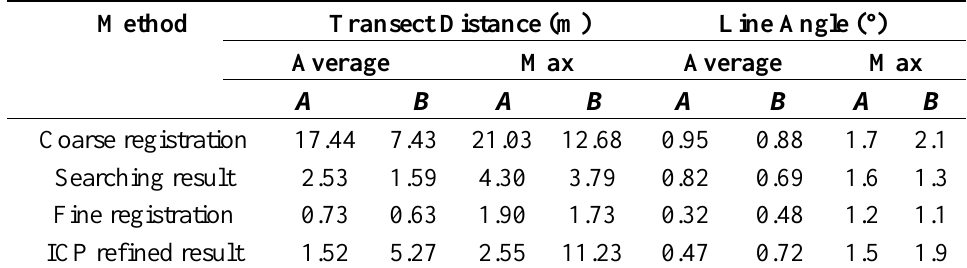
Table 2. Horizontal accuracy of the registration